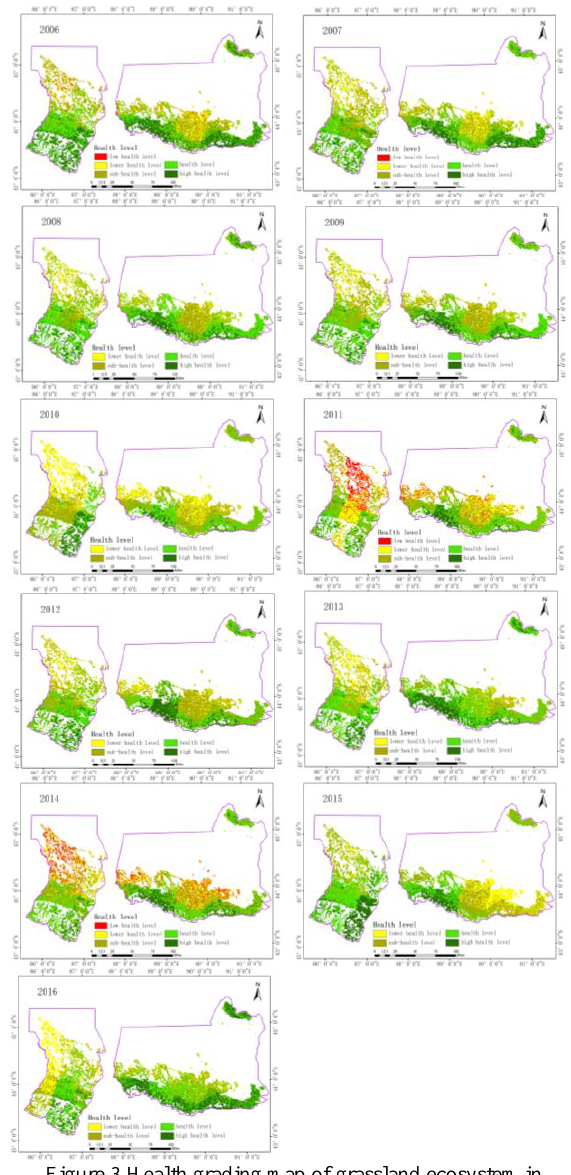
Figure 3.Health grading map of grassland ecosystem in Changji prefecture